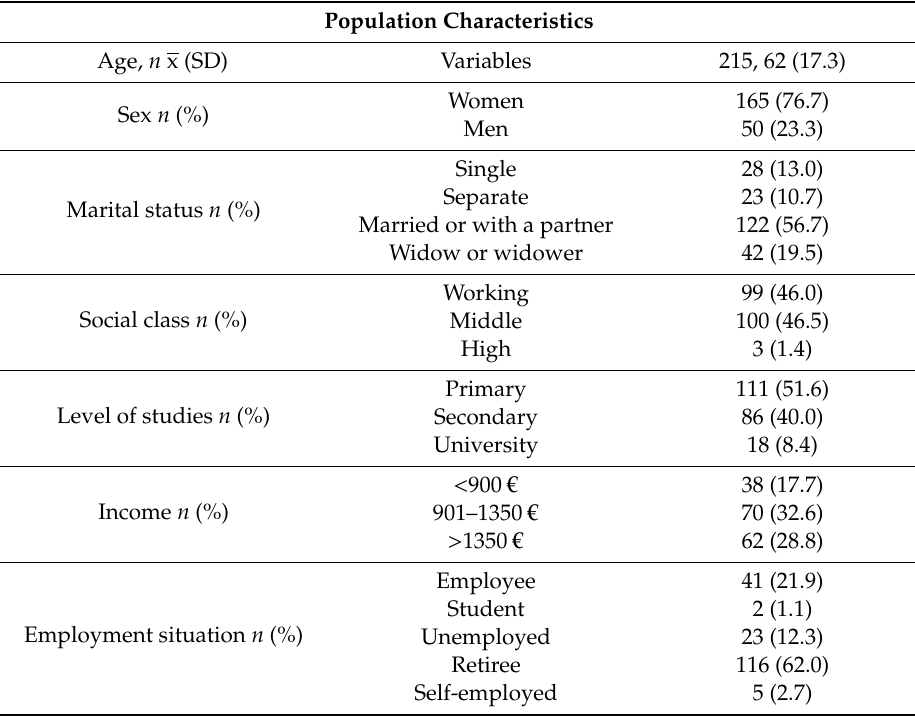
Table 3. Population sociodemographic